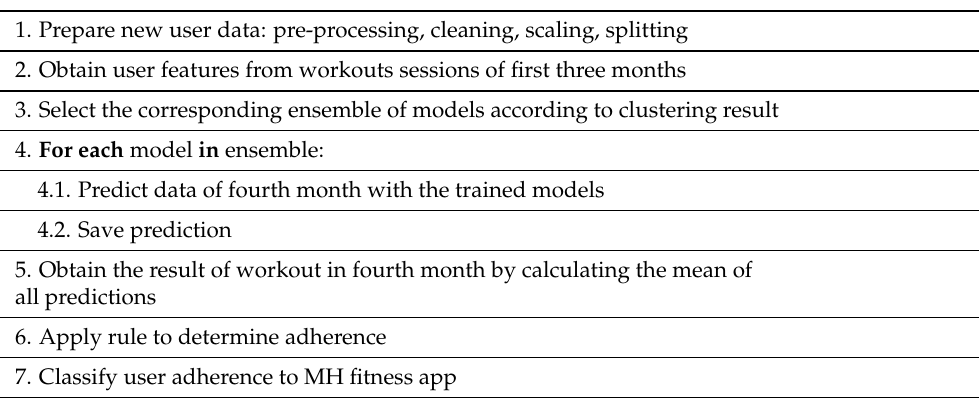
Table 6. Proposed framework algorithm: testing new